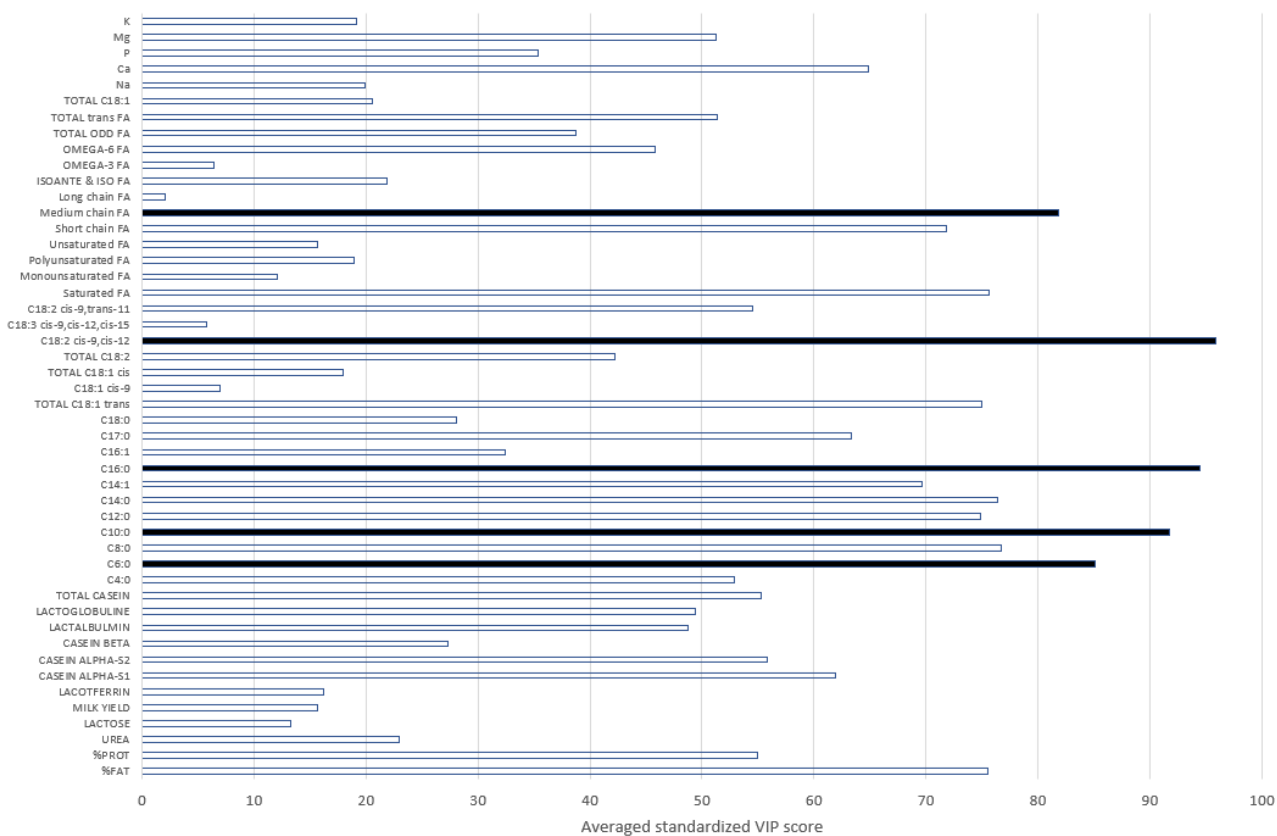
Figure 3. Yearly evolution of the predicted content of short-, medium-, and long-chain fatty acids in milk fat.